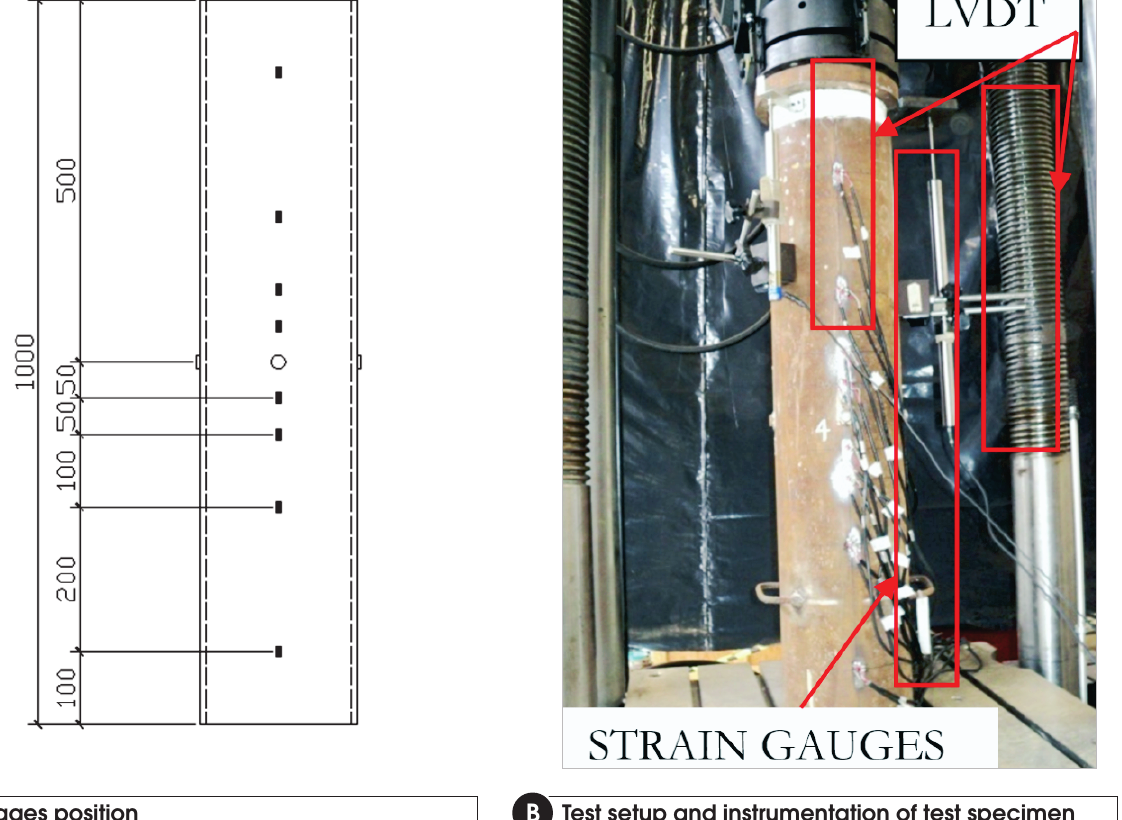
Example of instrumentation